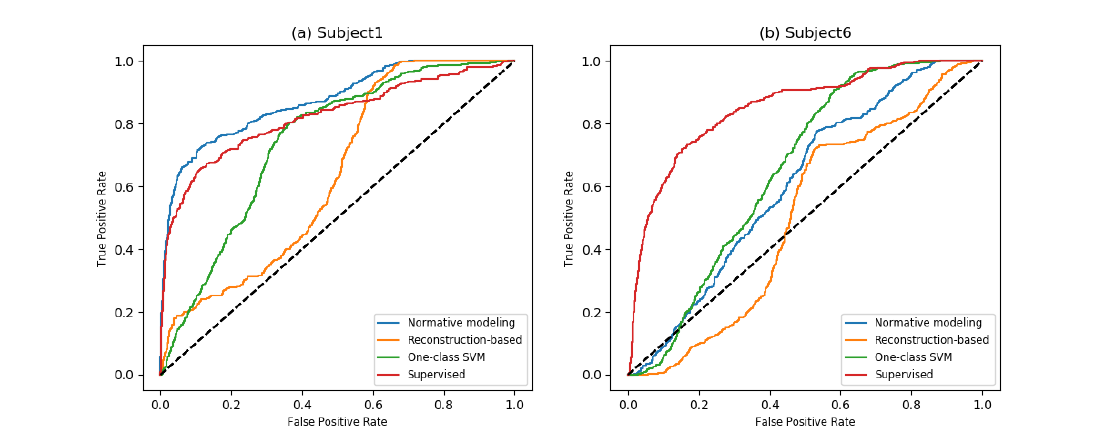
Figure 3. ROC curves corresponding to the reported AUCs for Subjects 1 and 6 ( a , b ) of the FOG dataset in Table